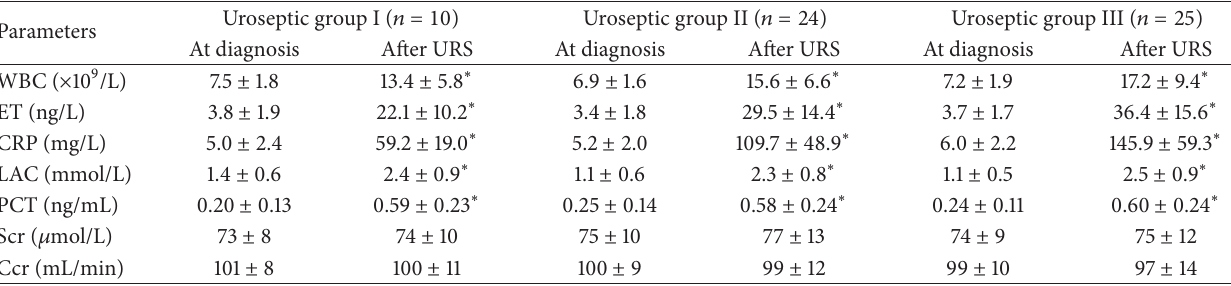
Table 2: Parameters of uroseptic patients before and after URS.